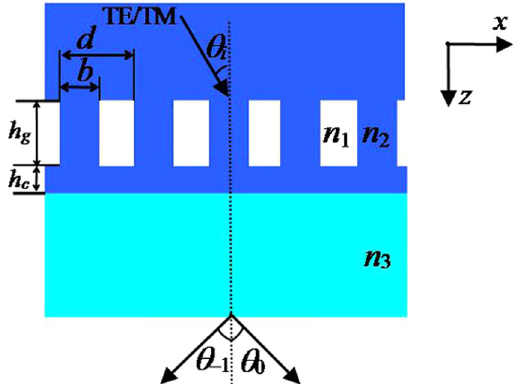
Figure 1. Schematic of a two-port sandwiched connecting-layer-based